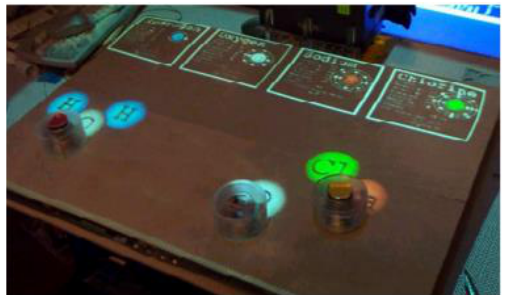
Figure 9. Sensetable for the education of chemical reactions [21].